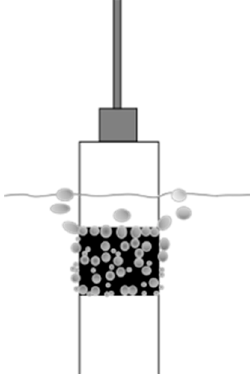
Figure 14. Illustration of entrapment of bubbles at the boundary between graphite and BN.